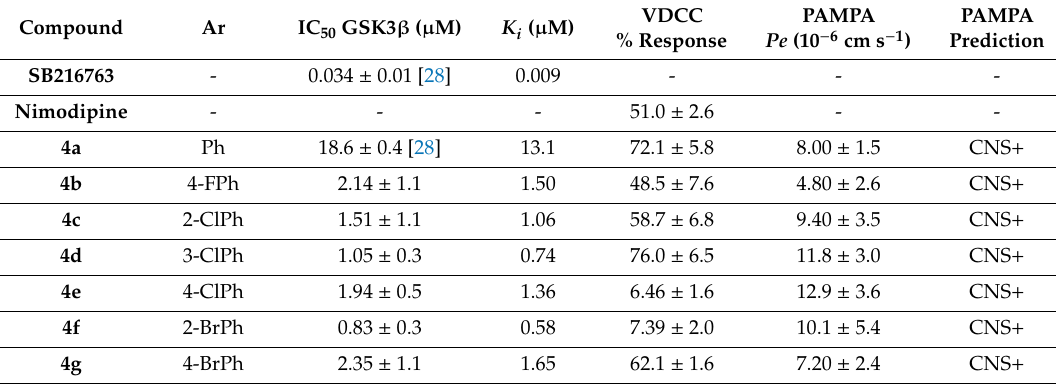
Table 2. GSK-3 β inhibition (IC 50 and Ki values), voltage-dependent Ca 2 + channels (VDCC) antagonism properties of derivatives 4a – l and reference